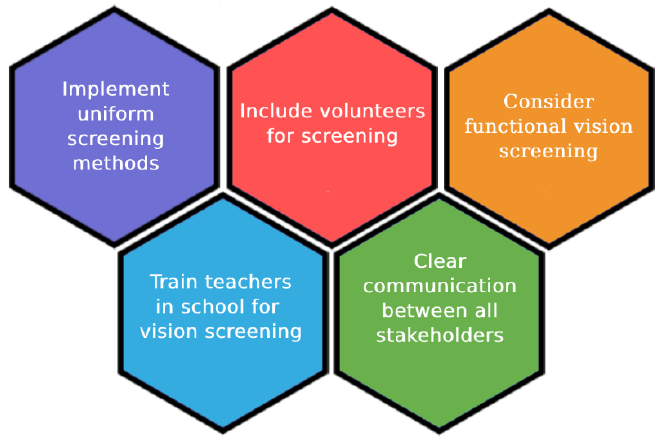
Figure 5. Current recommendations from the literature to fill the missing gaps in school vision screening programs. The colors in the figure depict recommendations for various methods and from various stakeholder groups.